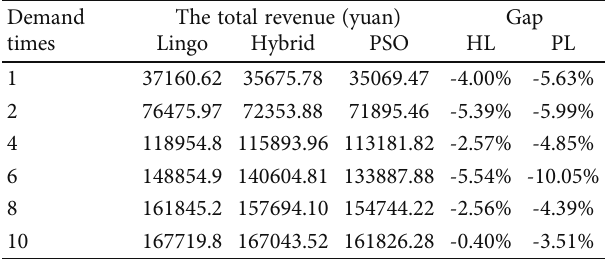
Table 6: Comparison of the solutions under di ff erent algorithms.